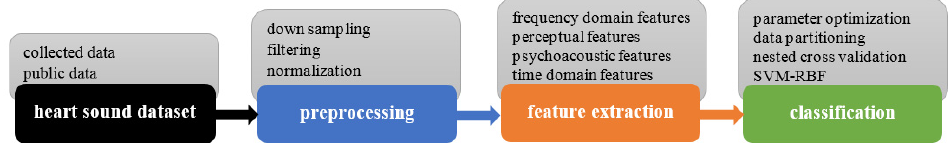
Figure 2. Block diagram for the overall methodology followed . It consists of four major blocks.